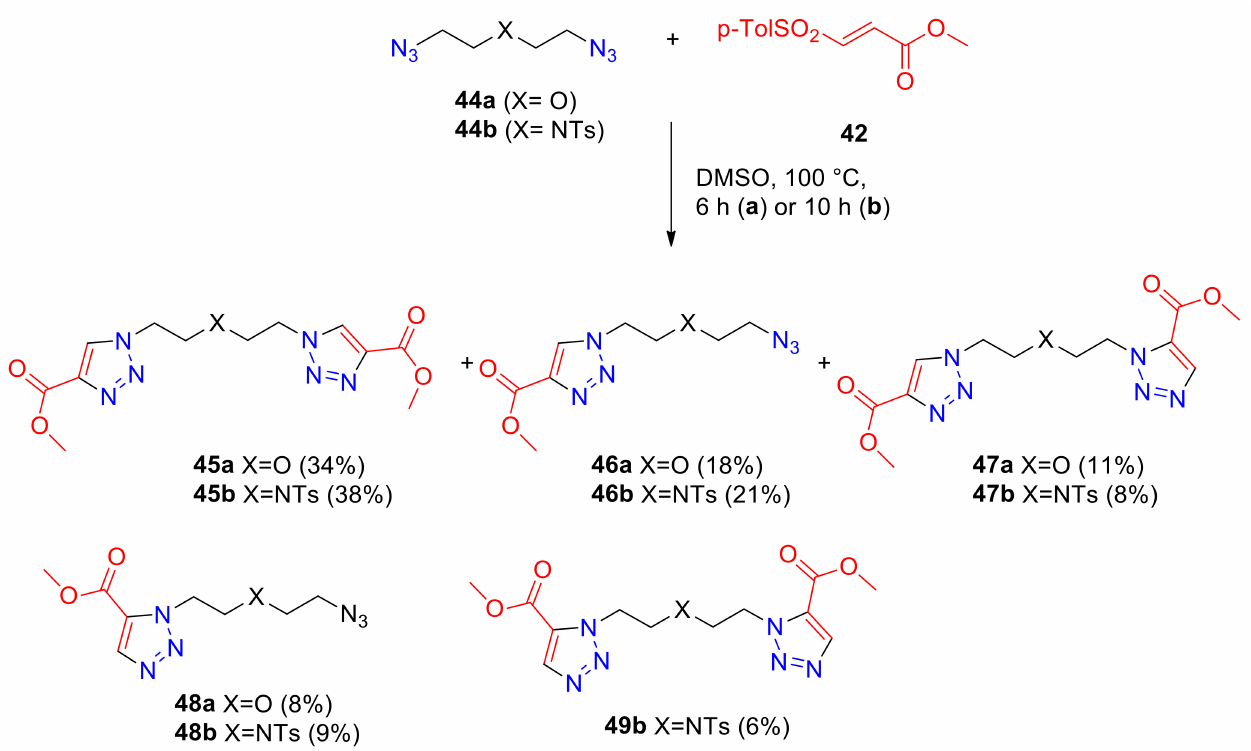
Scheme 15. Reaction of 42 with diazides 44a or 44b